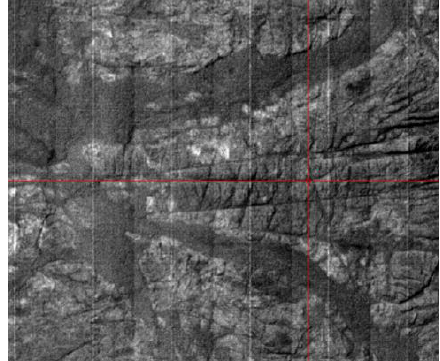
Figure 13. Experimental sample (rocks) schematic